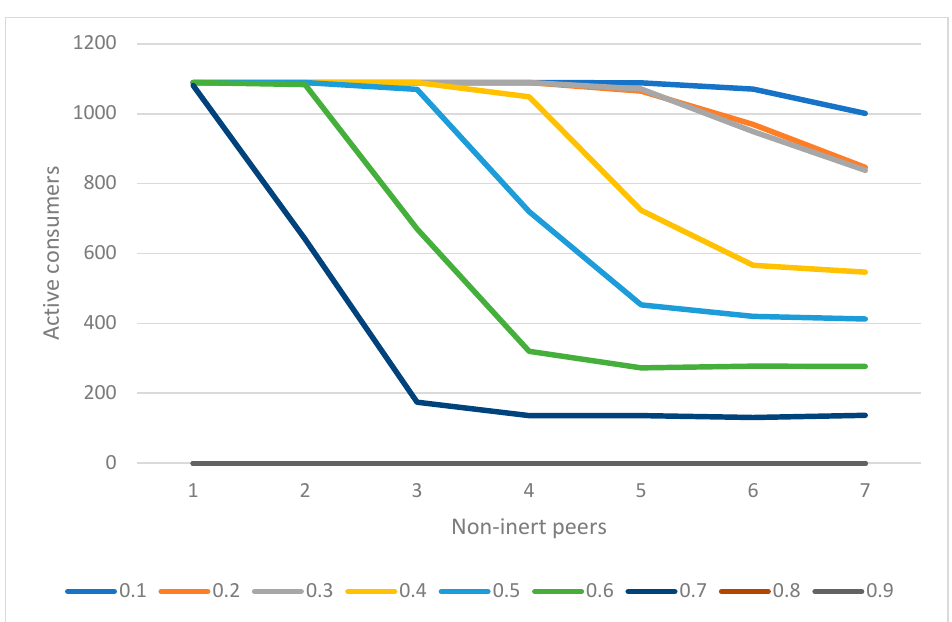
Figure 7. Consumer activity at moderate (medium)